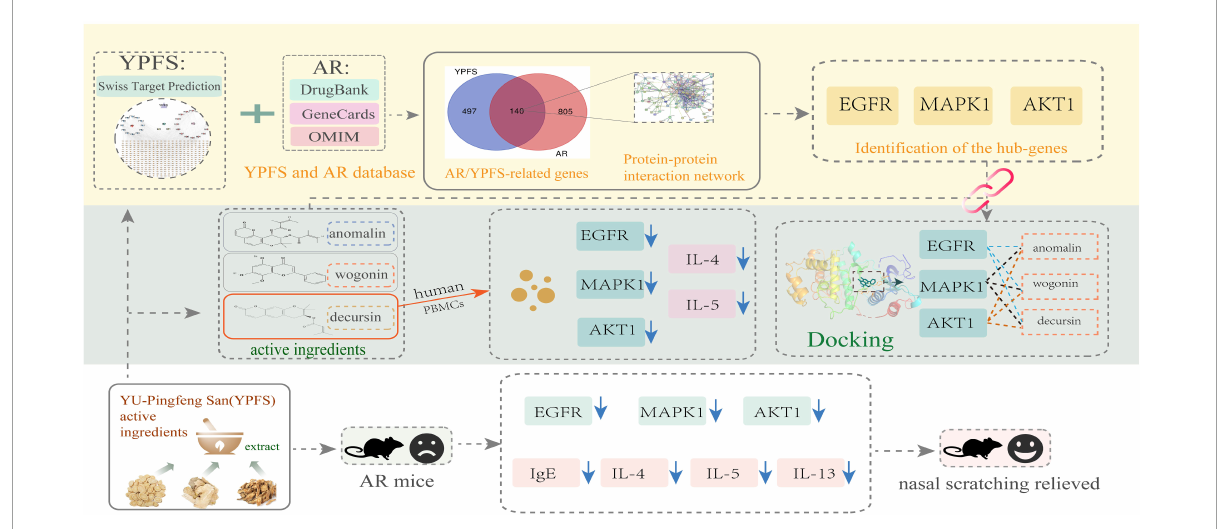
FIGURE1 A workflow chart for treatment of allergic rhinitis with YU-Pingfeng San based on network pharmacology analysis and experimental verification.